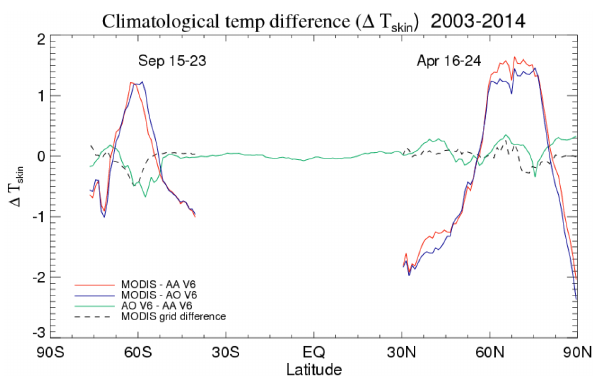
Figure 7. Zonal averaged values of T skin (MODIS) minus T skin (AA_V6) (red solid line), T skin (MODIS) minus T skin (AO_V6) (blue solid line), and T skin (AO_V6) minus T skin (AA_V6) (green solid line). The difference in spatial grid averages of the MODIS data between 4km × 4km and 1 ◦ × 1 ◦ is shown by the black dashed line. The difference values are calculated at one degree interval along each latitudinal belt. The climatological data periods are 16–24 April 2003–2014 over the Northern Hemisphere, and 15– 23 September 2003–2014 over the Southern Hemisphere.